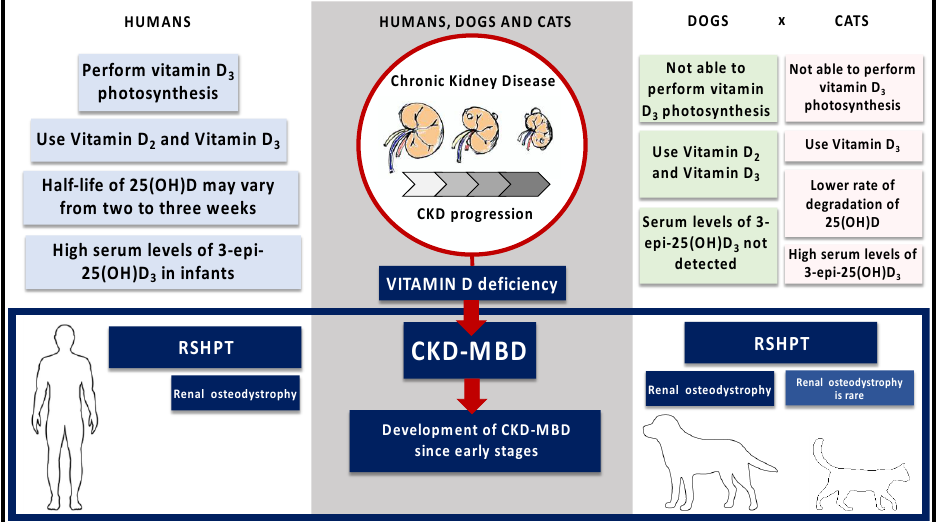
Figure 3. Comparison of vitamin D metabolism and the role of vitamin D disturbances in the development of CKD-MBD among dogs, cats, and people. Humans are able to perform vitamin D 3 photosynthesis, whereas dogs and cats are not [79–81]. Both dogs and humans use Vitamin D 2 and Vitamin D 3 , but cats discriminate between these two metabolites [88]. In comparison with humans, cats may have a longer half-life of 25(OH)D because of a lower rate of degradation of 25(OH)D [88]. High serum levels of 3-epi-25(OH)D 3 were previously reported in infants, and it has recently been found great amounts of 3-epi-25(OH)D 3 in the serum of cats [90,125]. The vitamin D deficiency is associated with the CKD-MBD since early stages in humans, dogs and cats. RSHPT commonly occurs in these species, but the development of renal osteodystrophy is rare in cats